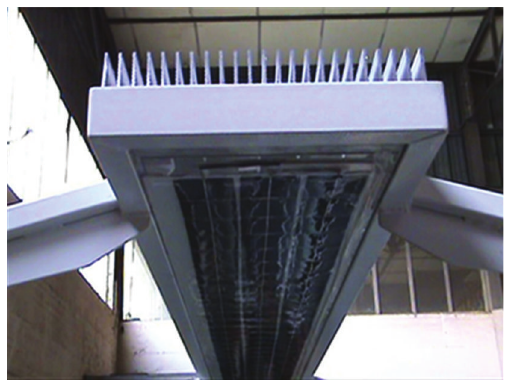
Figure 4: Detail of the PV panel and the finned surface.